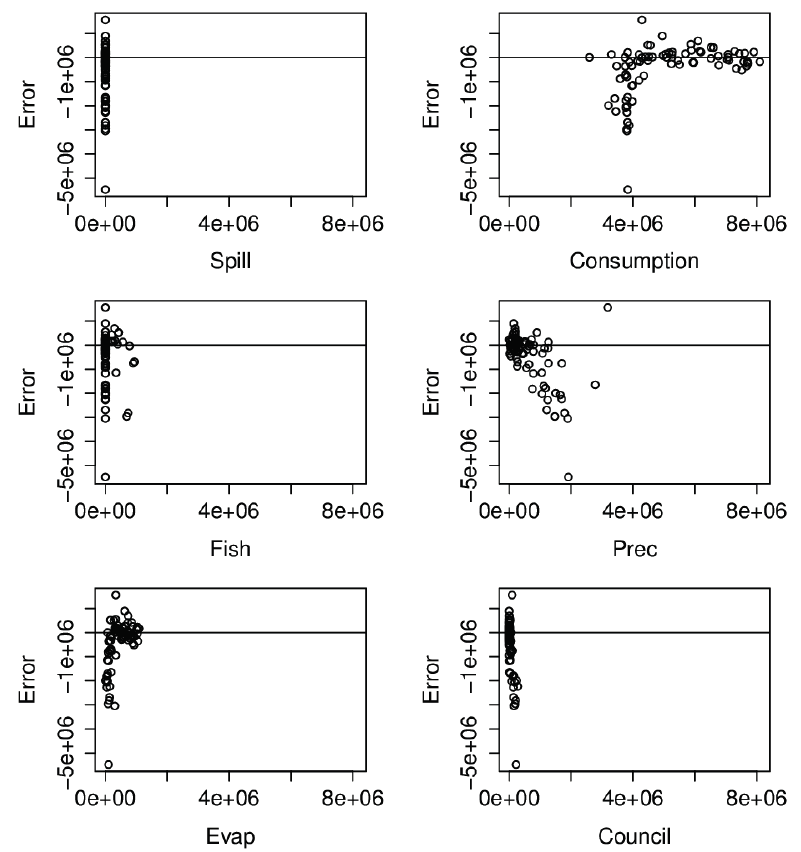
Figure 5. Values of simulated change in storage minus the observed change in storage (error) versus monthly spill, consumption, fisheries release, precipitation, evaporation and inputs from Council when spill events did not take place.